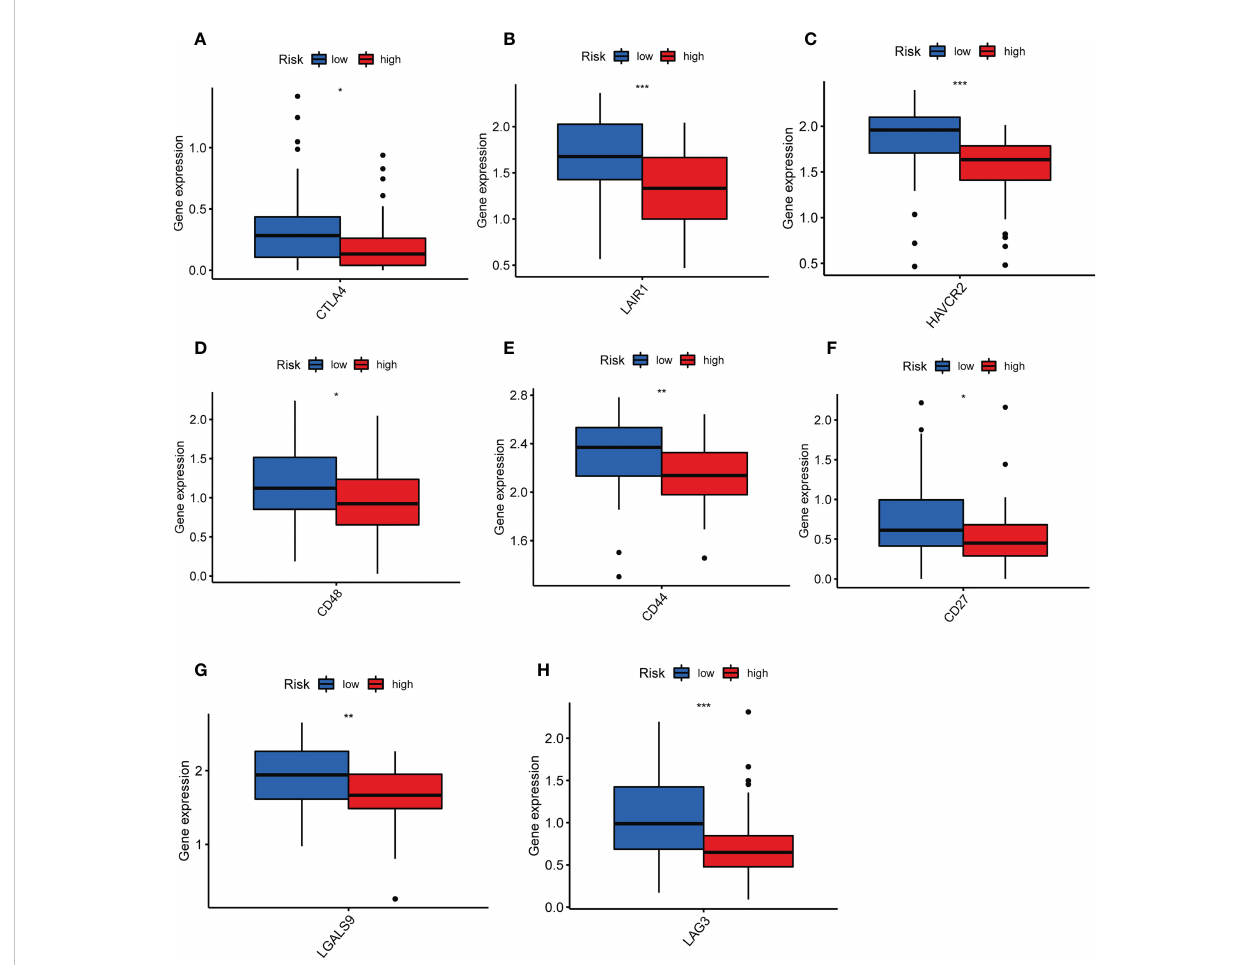
FIGURE 6 Differential analysis of immune checkpoints to assess the predictive power of TILscore immunotherapy. Differences in expression levels of immune checkpoints CTLA4 (A) , LAIR1 (B) , HAVCR2 (C) , CD48 (D) , CD44 (E) , CD27 (F) , LGALS9 (G) , and LAG3 (H) in the low- and high-risk groups. *p < 0.05; **p < 0.01; ***p <